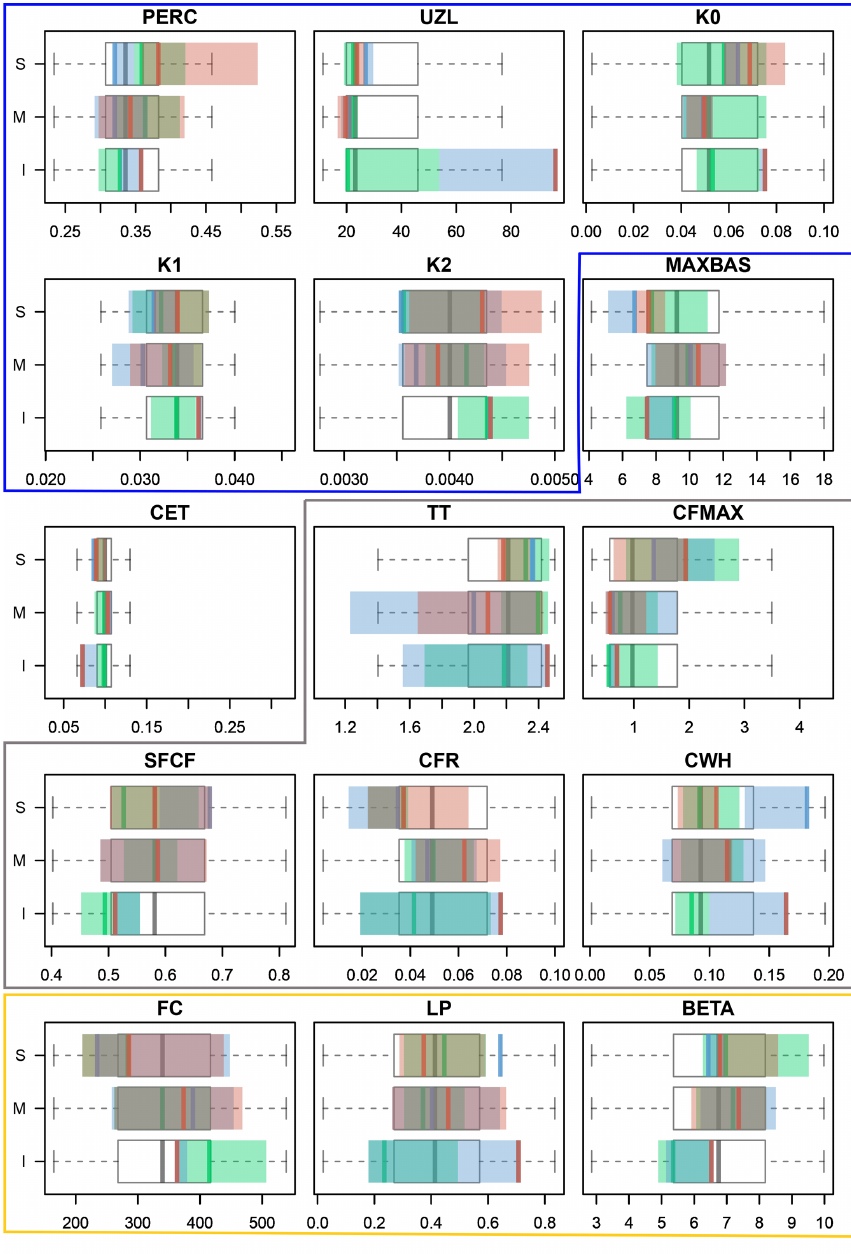
Figure 5. Box plots showing the variability in the hydrological parameter sets selected as the representative parameter sets over 100 mete- orological scenarios chosen with three methods. The white box plots illustrate the entire parameter ensemble (i.e. 100 sets); outliers are not presented. I: infimum; M: median; and S: supremum set. Units as in Table A1. The blue box surrounds parameters from the response routine, the grey box from the snow routine and the yellow from the soil moisture routine. MAXBAS is the only parameter from the routing routine, and CET is a potential-evaporation correction